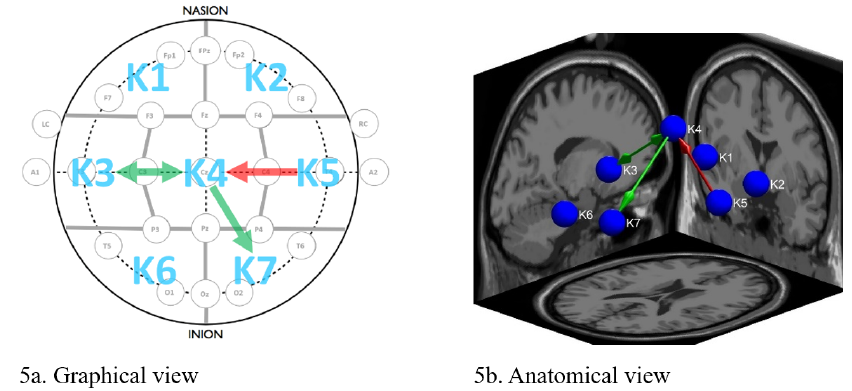
Figure 5. Estimated brain connectivity in the problem-identifying phase for verbal intelligence tasks. Note: Arrows represent causality directions (green arrow: engineering > liberal arts; red arrow: liberal arts > engineering).